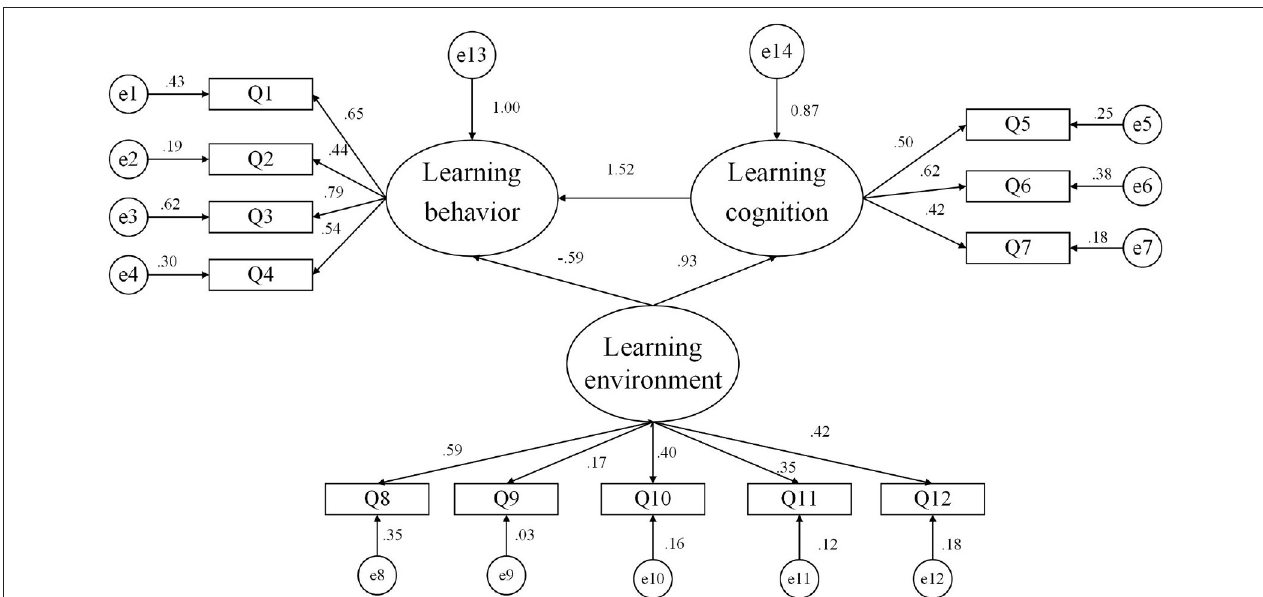
FIGURE 2 | Initial structure diagram of the measurement model of online learning’s effect on college students.